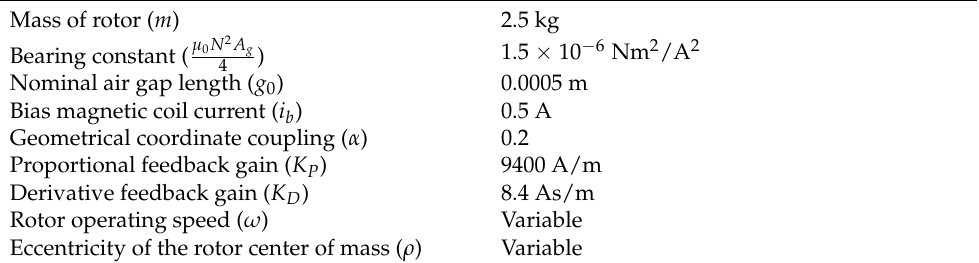
Table 1. Parameters for the numerical simulation model. Mass of rotor ( m